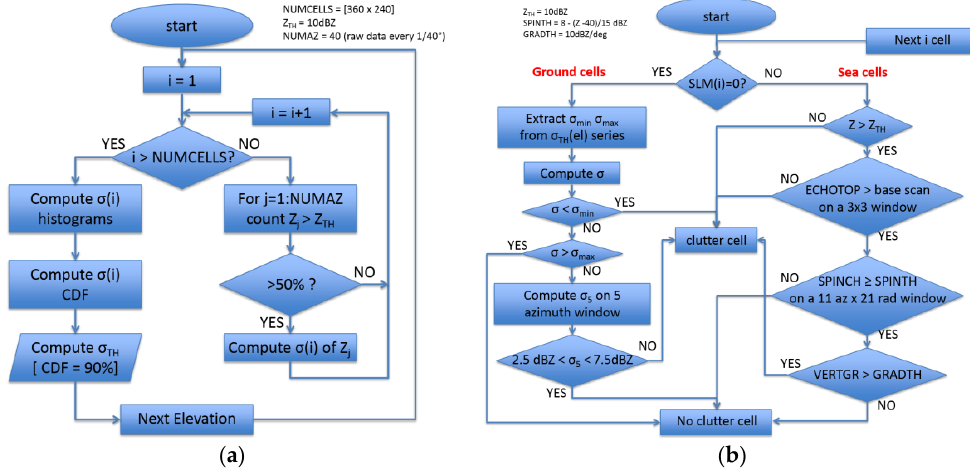
Figure 3. Flow chart of the clutter removal scheme: ( a ) Set-up in clear air conditions; ( b ) Operational sea and ground clutter identification algorithm. Atmosphere 2017 , 8 , x FOR PEER REVIEW